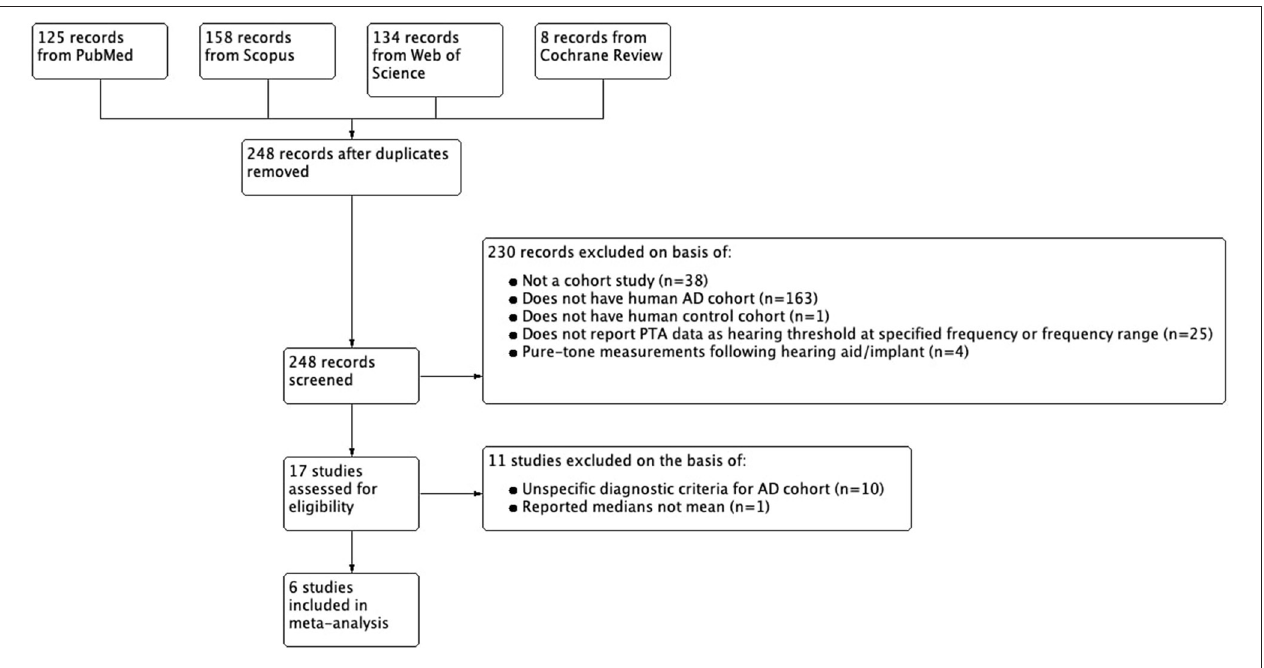
FIGURE 1 | Flowchart of inclusion and exclusion of studies.